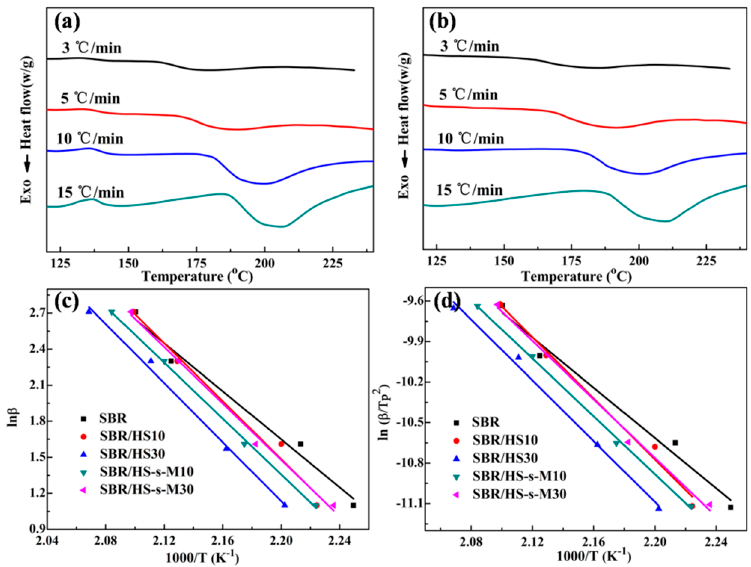
Figure 6. Typical dynamic DSC curves of ( a ) SBR/HS30 compounds and ( b ) SBR/HS-s-M30 compounds; linear fitting for calculating apparent activation energy (Ea) by the ( c ) Ozawa method and ( d ) Kissinger method. Table 2. Vulcanization characteristics and apparent activation energy (Ea) of SBR compounds obtained from DSC.